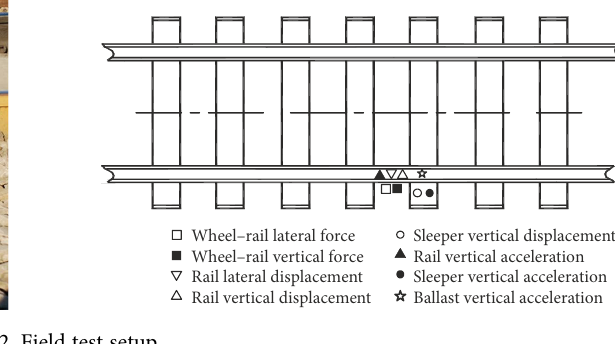
Figure 2. Field test setup